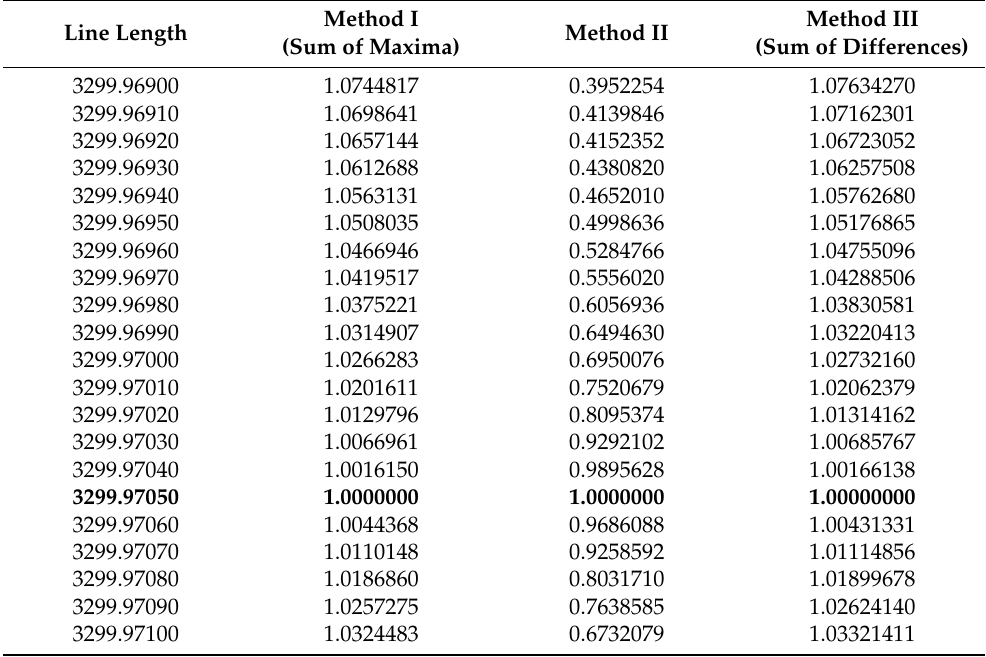
Table 16. Image line length estimation results for the accuracy ∆ =